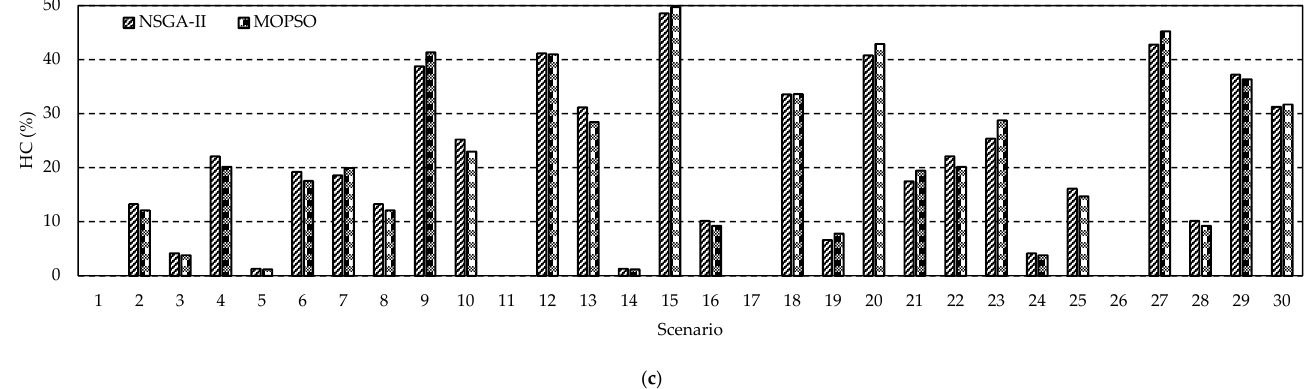
Figure 13. Hosting capacity (HC) at each scenario: ( a ) 59-node, ( b ) 83-node, and ( c ) 415-node.